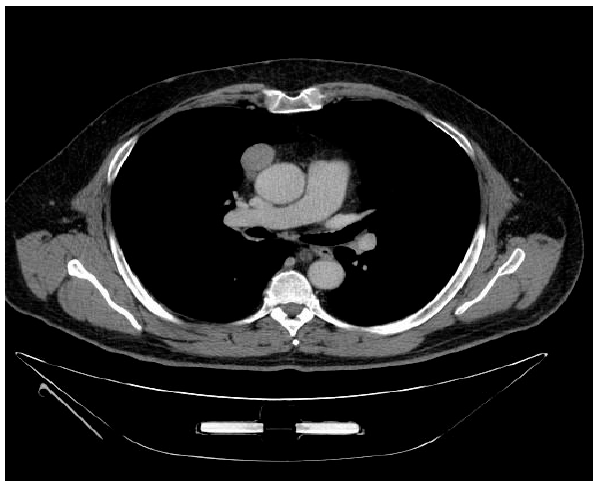
Figure 3. CT image showing oval shape, regular contour thymoma.